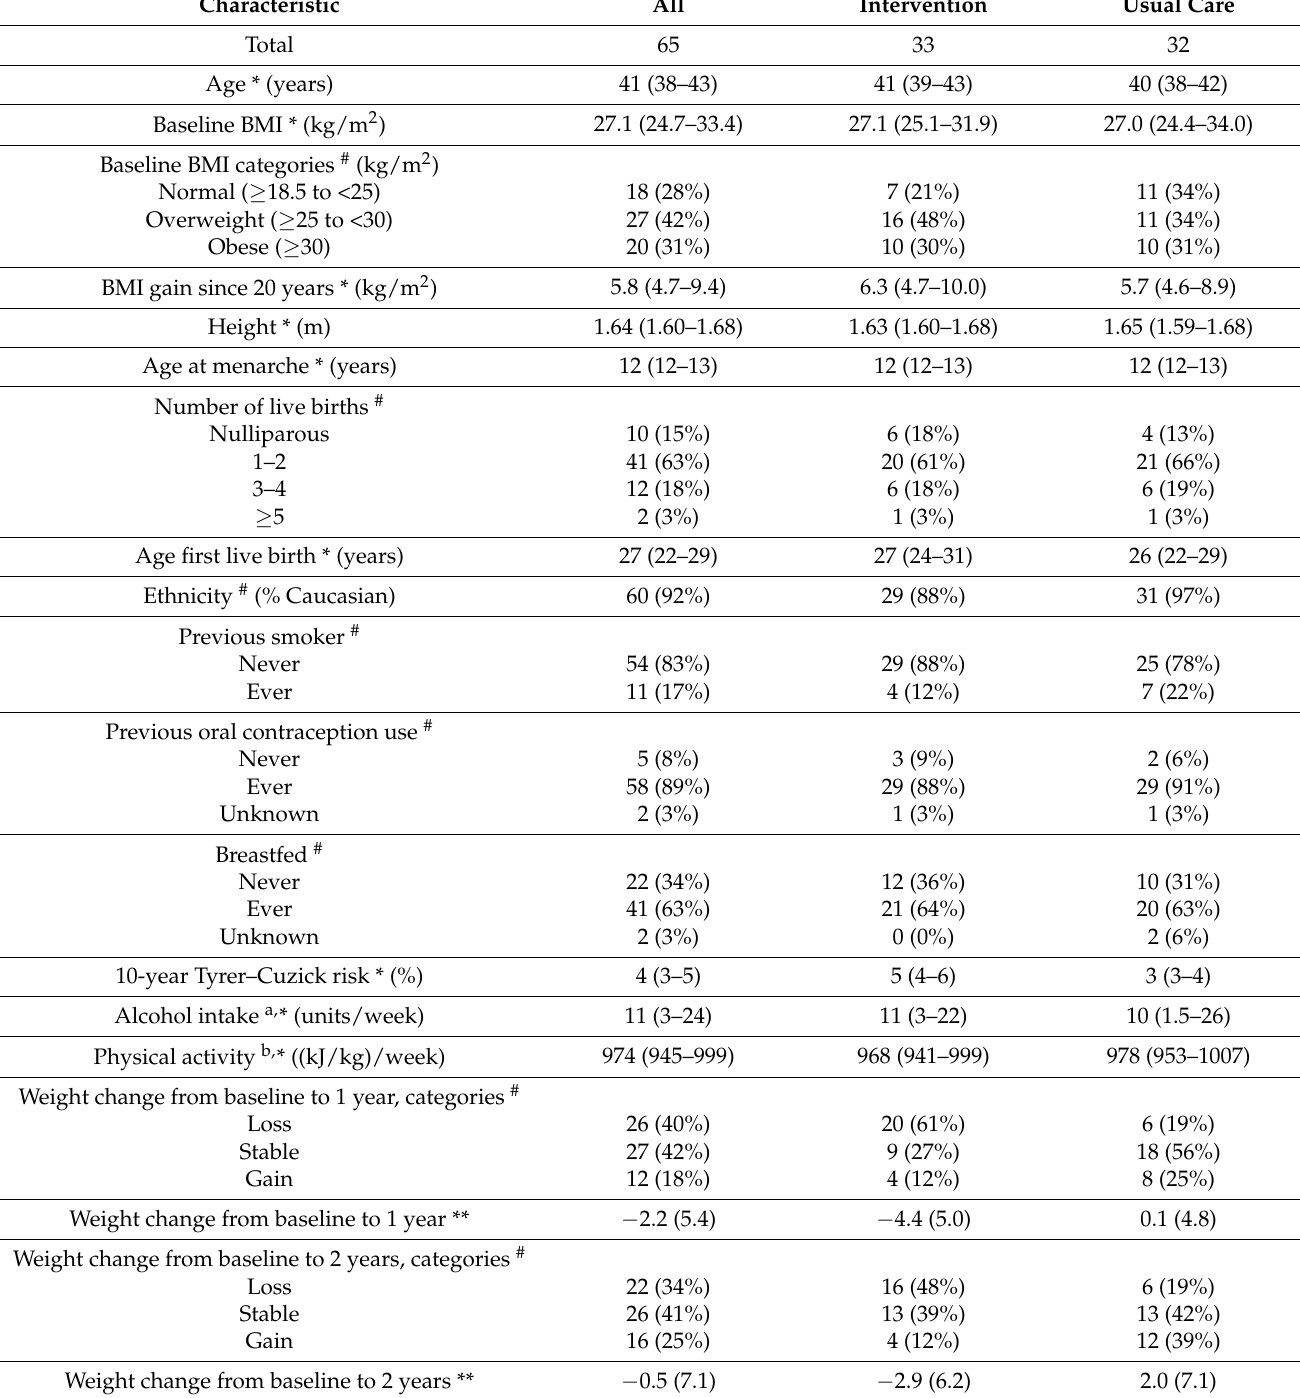
Table 1. Participant characteristics at study